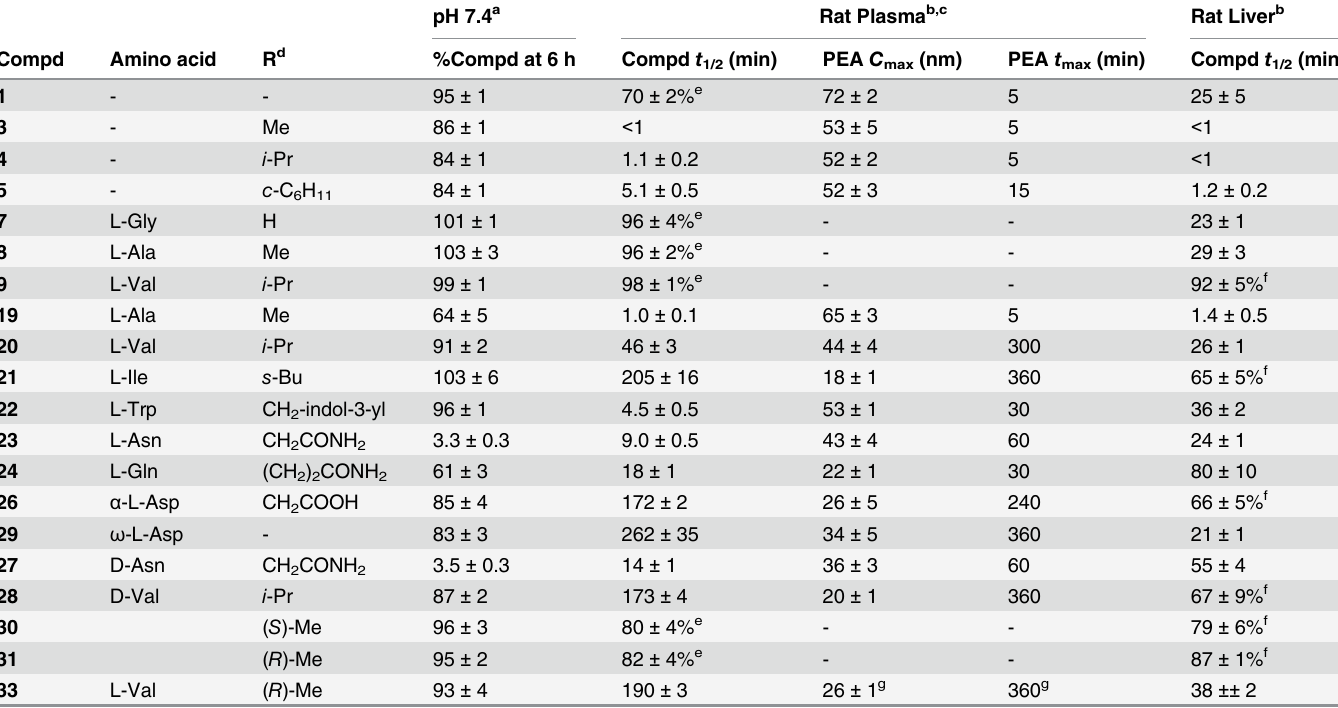
Table 1. Stability data for palmitoylethanolamide (PEA, 1) and compounds 3 – 5, 7 – 9, 19 – 24, 26 – 31,